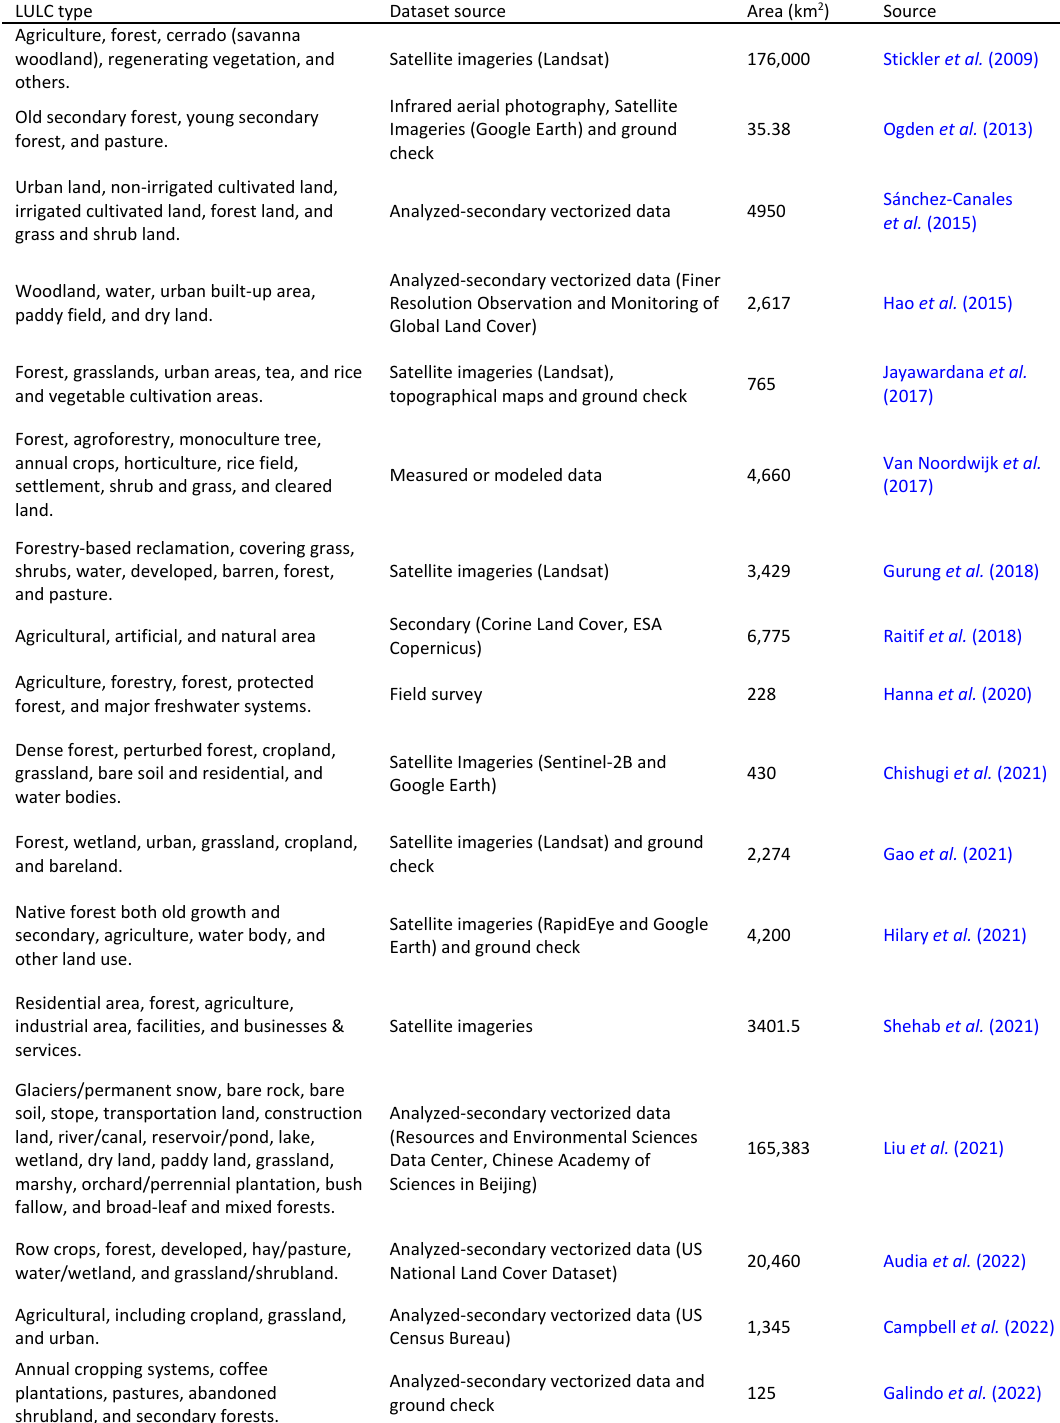
Table 2: Assessing landscape data for RES research